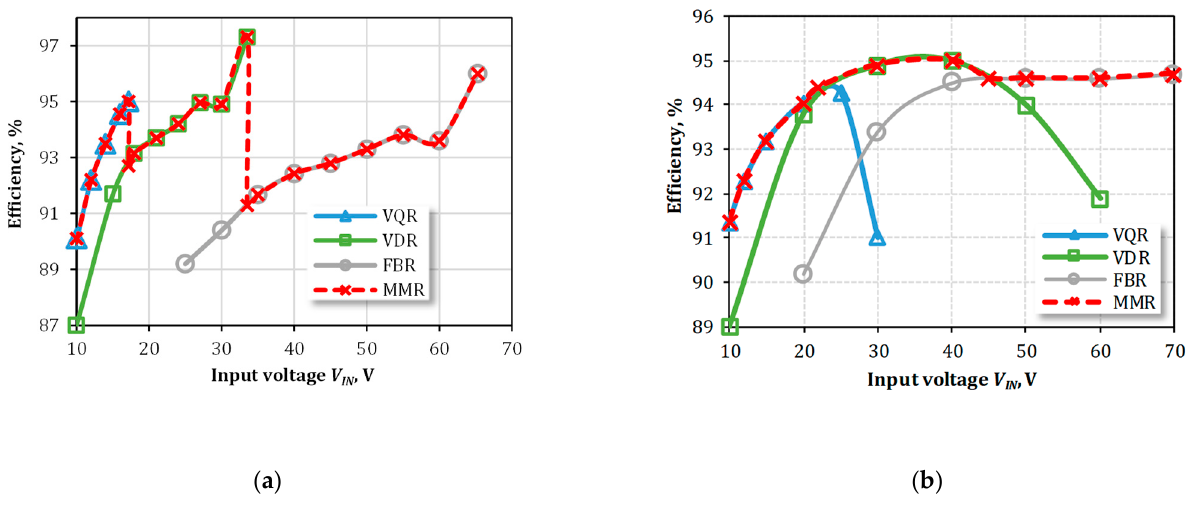
Figure 9. Experimental efficiency curves obtained at the power of 100 W for different types of front-end inverters: ( a ) FBqZSI and ( b ) BHBI. Table 5. Example of thermal cycling observed in the FBqZSI-based converter at V th 1